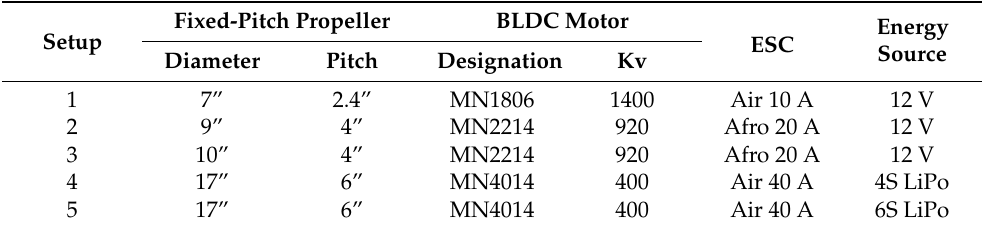
Table 1. Considered EPU setups.